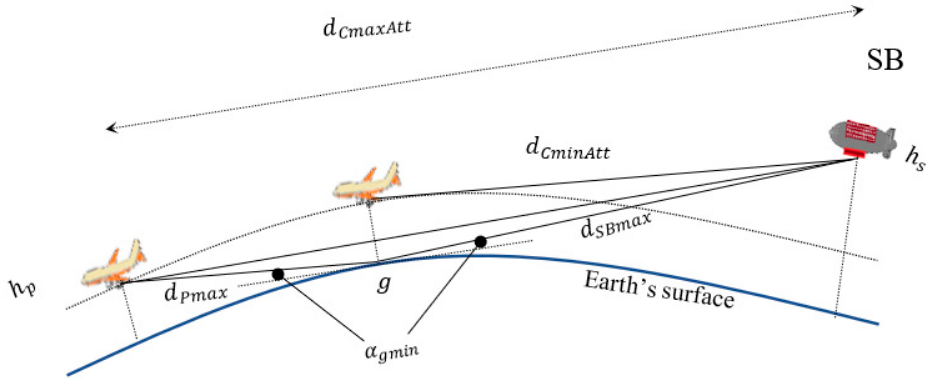
Figure 14. Geometry for handover scenarios in SB network for aviation.